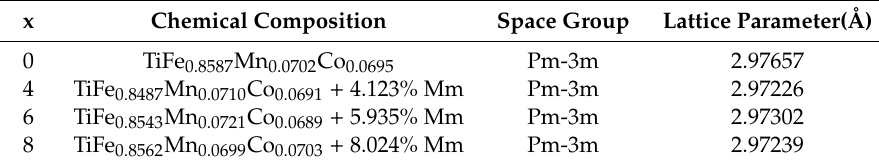
Table 1. The chemical composition and crystallographic data of TiFe 0.86 Mn 0.07 Co 0.07 + x% Mm (x = 0,4,6,8).